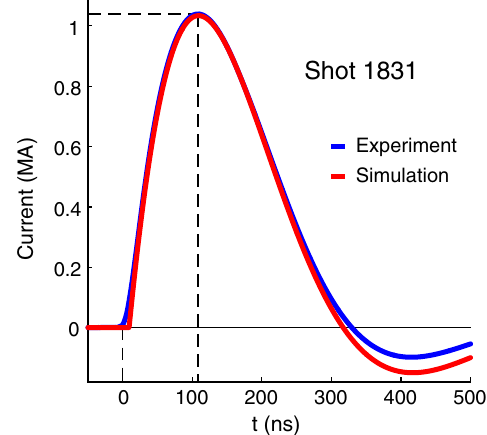
FIG. 8. Comparison of output current from simulation and experiment. Simulation result is from the circuit show in Fig. 7 using the component values listed in Sec. III with an initial charge voltage of 200 kV.